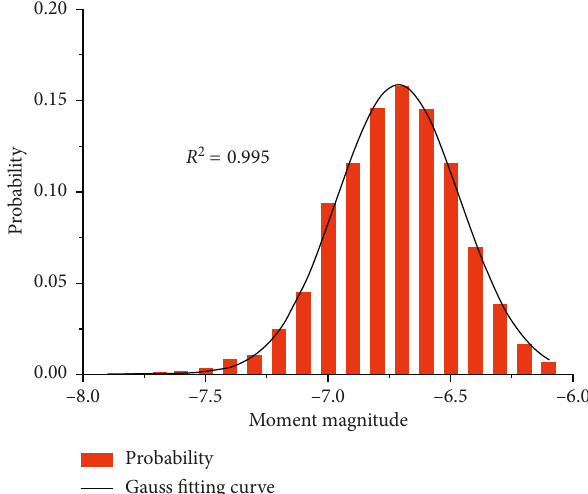
Figure 8: Distribution of the moment magnitude probability in the acoustic emission event under uniaxial